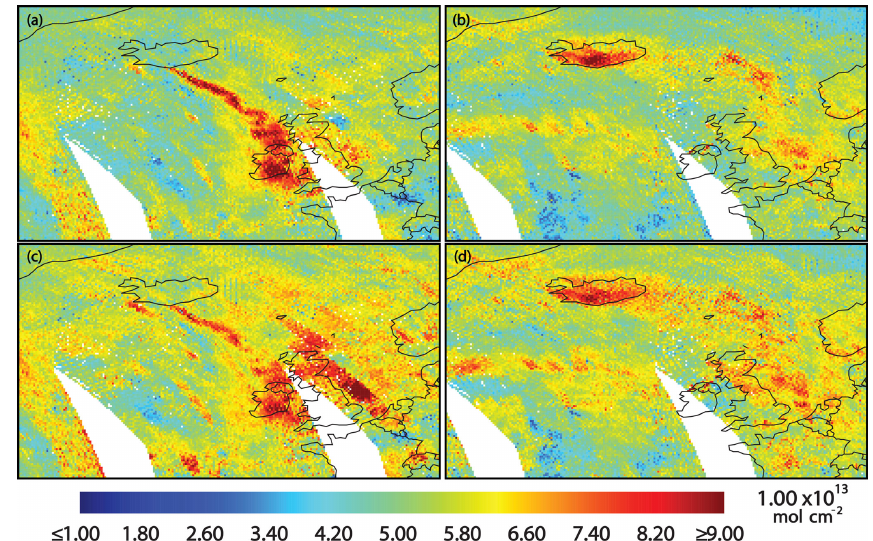
Figure 13. Daily average BrO VCDs from Eyjafjallajökull on 5 May 2010 (a) and 17 May 2010 (b) produced using the operational SO 2 cross sections for the same days (c) and using the Vandaele et al. (2009) SO 2 cross sections (d)